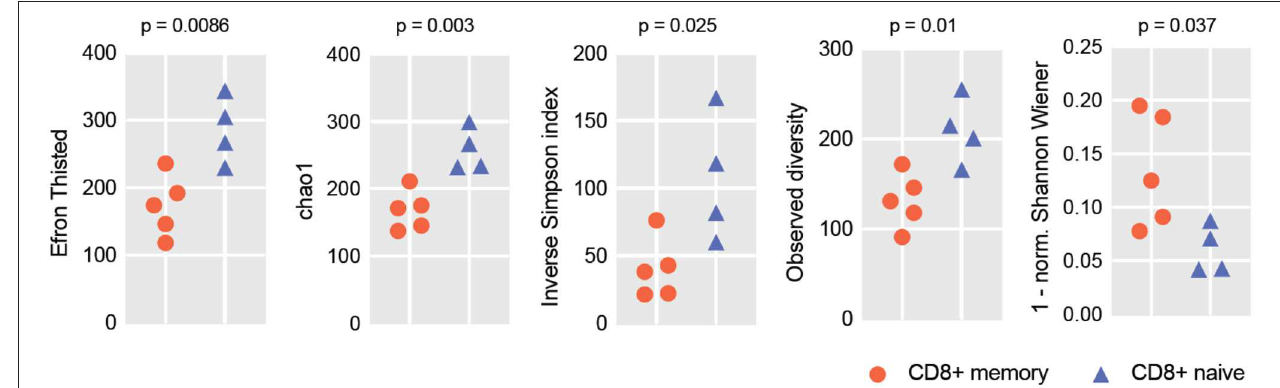
FIGURE 1 | RNA-Seq-based TCR repertoire diversity in naïve and memory CD8 + T cells. Diversity metrics calculated for naïve and effector CD8 + TCR α + β (combined) CDR3 repertoires are shown. Note that each sample is represented by 1,500 randomly chosen CDR3-covering sequencing reads for normalization. Observed diversity is a total number of unique clonotypes in a sample, so it takes into account all clonotypes. Chao1 depends mostly on the representation of singletons and doubletons—clonotypes represented by one and two reads, respectively. Both Chao1 and Efron-Thisted indices estimate relative total TCR diversity, similar to the estimation of species richness. These numbers should not be, of course, understood as true total diversity, but only as a lower bound calculated based on a given sample size. Inverse Simpson’s Diversity Index takes into account both richness and evenness. [1-normalized Shannon Wiener] represents